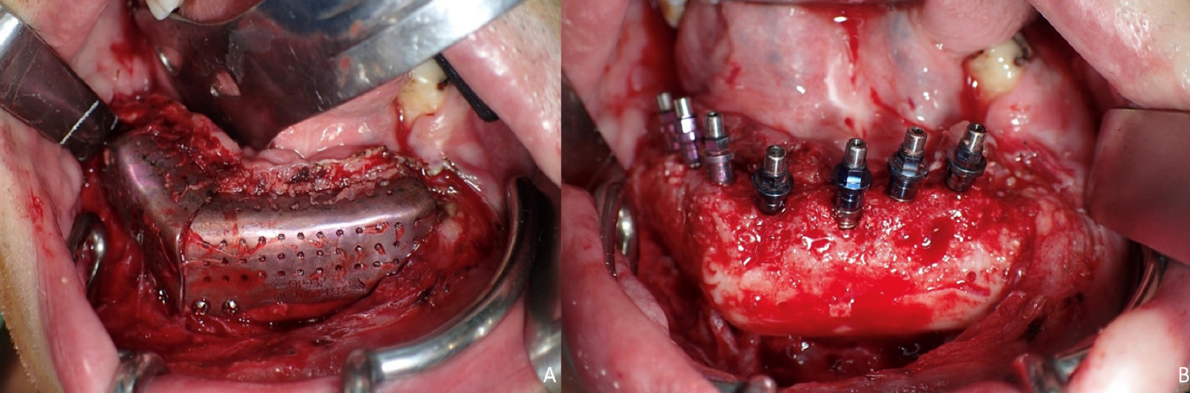
Figure 8. Ossification of the graft. ( A ) Intraoral approach showing the three-dimensional preservation of the customized mesh. ( B ) Removal of the titanium mesh. Accuracy of vertical reconstruction of the fibula with preservation of the horizontal dimension of the bone and immediate placement of Ticare ® dental implants.